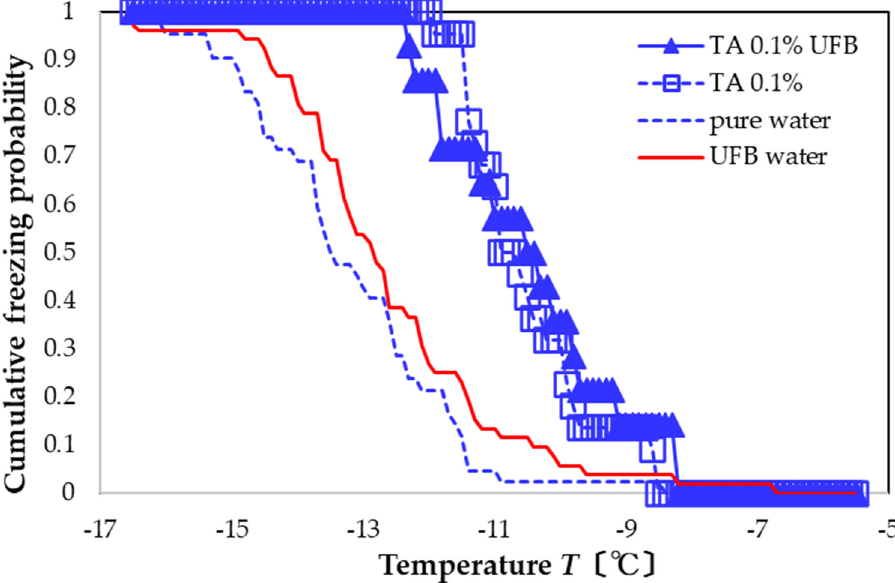
Figure 6. Freezing curve of aqueous solution with 0.1 wt% TA dissolved in water with UFBs (solid blue). Other curves shown for comparison (same as Figure 2).